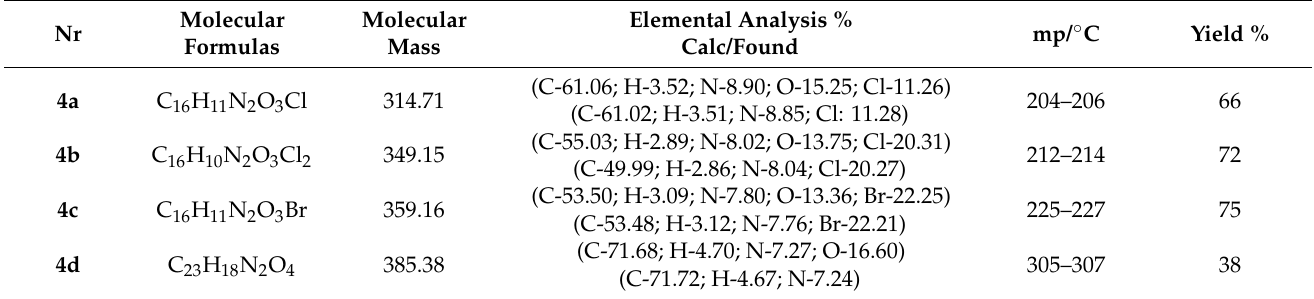
Table 1. Physical properties of compounds 4(a-e) and 5(a-e) and their elemental analysis.